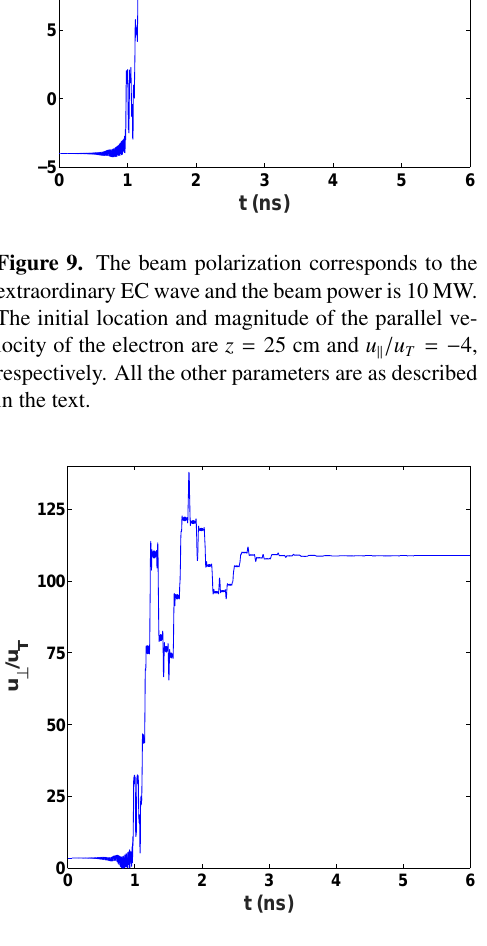
Figure 10. A plot of u ⊥ / u T as a function of time for the same parameters as for Fig.